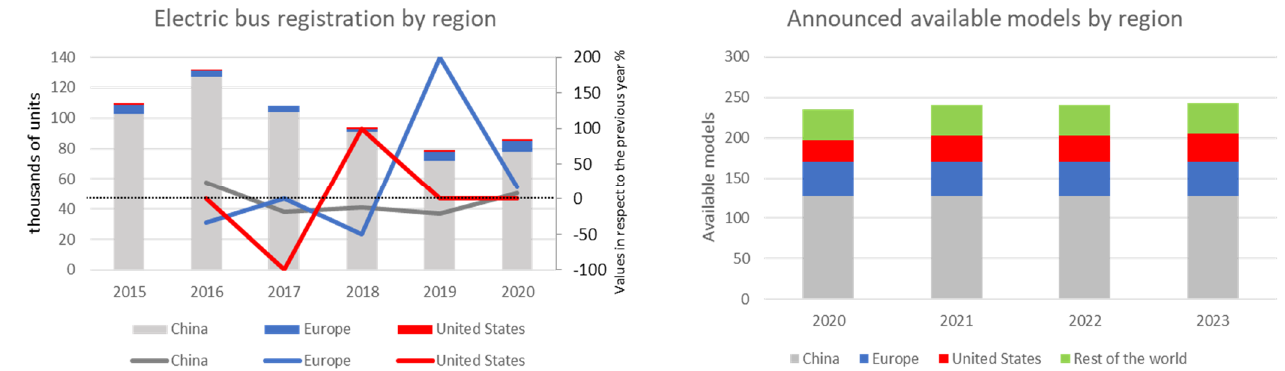
Figure 1. Electric bus registration and announced available models by region. Elaboration of data from IEA [13].